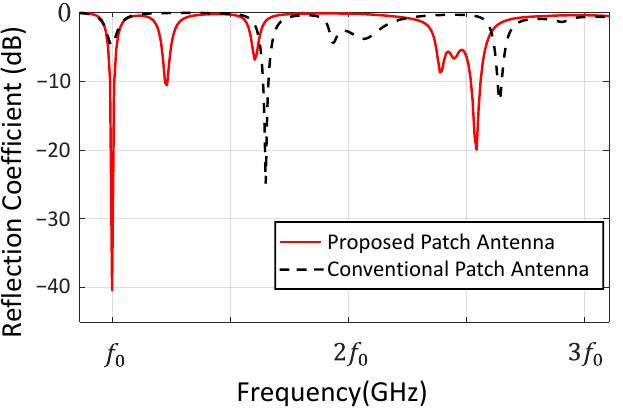
Figure 2. Reflection coefficient of the proposed patch antenna and conventional patch antenna (simulation).